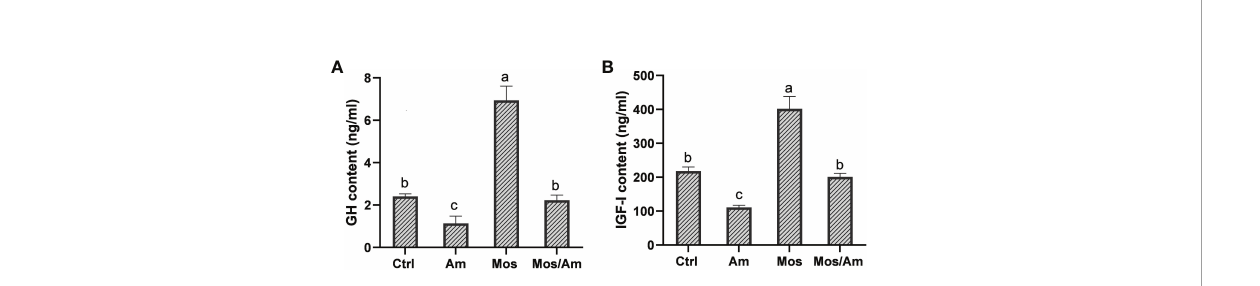
FIGURE 1 Effects of dietary MOS on the growth hormone content of the common carp under ammonia stress for 30 days. Values are expressed as mean ± standard error (SE) from triplicate groups. Bars with different letters differ signi fi cantly from those of other groups ( P < 0.05). GH content (A) , IGF-I content (B) .